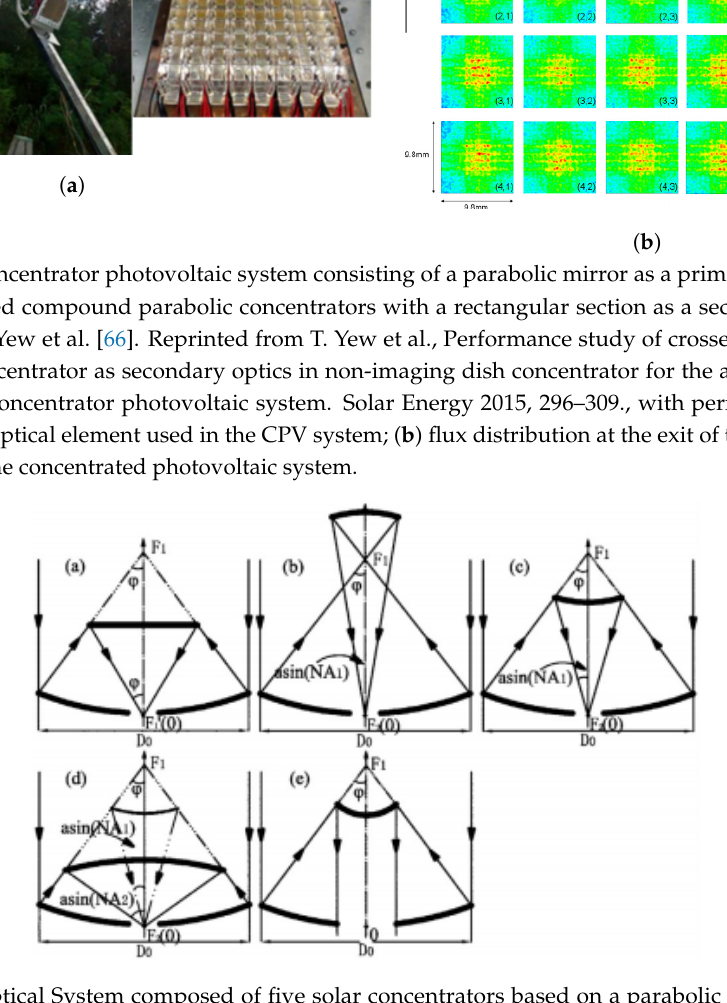
Figure 36. Optical System composed of five solar concentrators based on a parabolic mirror as the primary optical element; the secondary ones are: a flat mirror ( a ), an ellipsoidal mirror ( b ), an upper hyperboloidal mirror ( c ), a lower hyperboloidal mirror ( d ) and a paraboloidal mirror ( e ), investigated by Zhang et al. [70]. Reprinted from Y. Zhang et al., Comparison of different types of secondary mirrors for solar application. Optik 2014, 1106–1112, with permission from